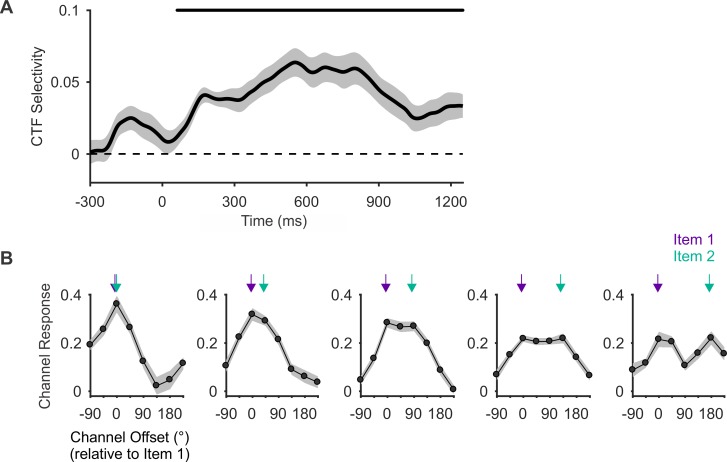
Testing whether multivariate patterns of alpha-band power generalize between one-item and two-item trials.(A) The spatial selectivity of alpha-band CTFs across time (measured as CTF slope; see Materials and methods) in the two-item condition when the IEM was estimated using the one-item condition. The markers at the top of the panel indicate the period of above-chance selectivity obtained using a cluster-based test. (B) Mean delay-period (averaged from 250–1,250 ms) channel-response profiles as a function of the distance between the items. The arrows above each subplot mark the channel(s) tuned for the positions of the 2 stimuli. The shaded error bars reflect ±1 SEM across observers. Data are available at https://osf.io/47cmn/. CTF, channel-tuning function; IEM, inverted encoding model.